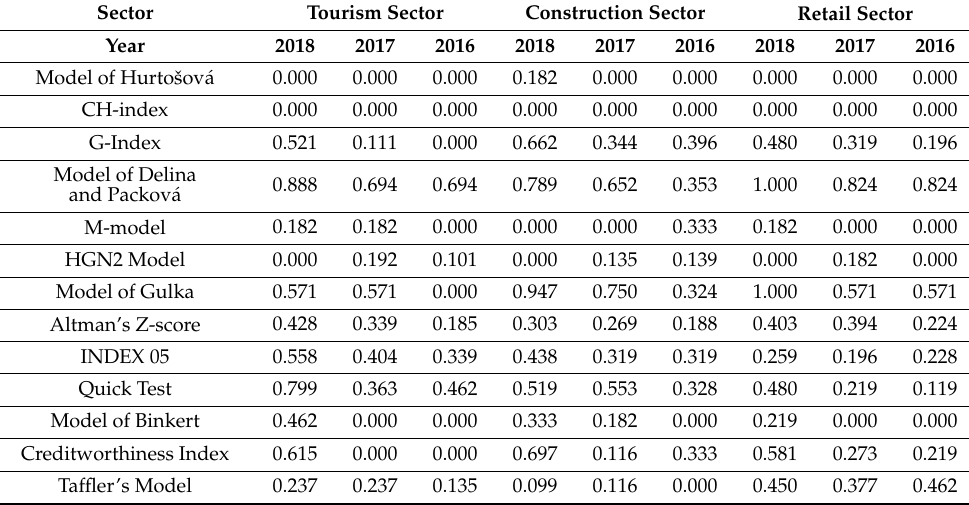
Table A5. Results of testing models for each sector using the F1 Score measure.